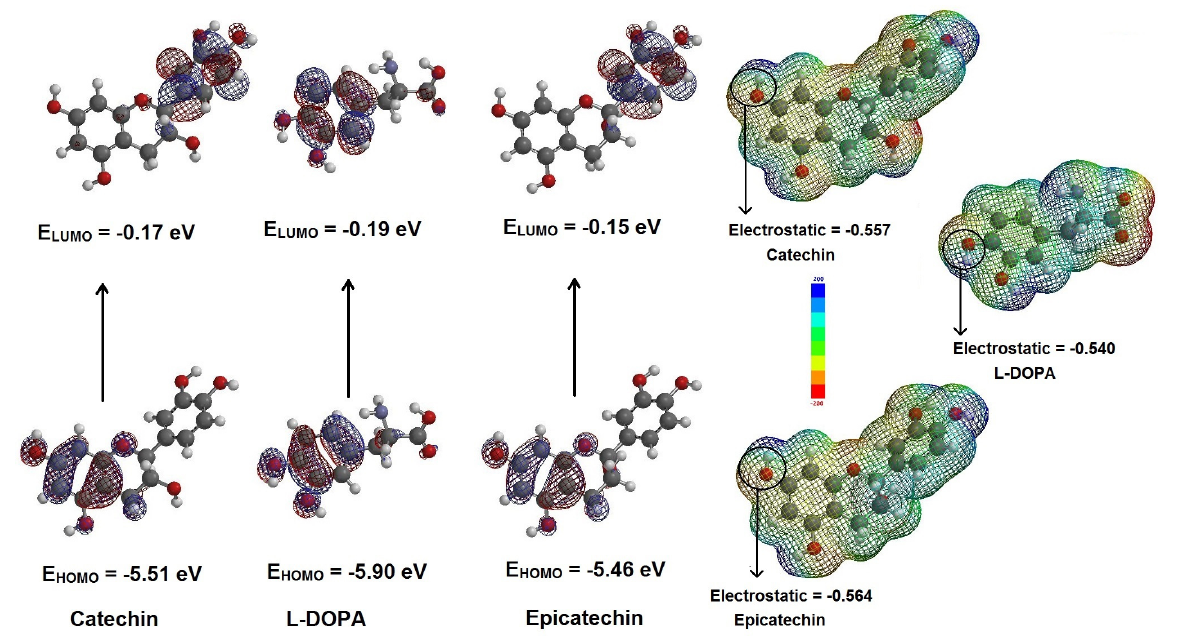
Figure 4. Theoretical HOMO-LUMO and electrostatic potential map (from the ground-state calculations at the DFT/ B3LYP/-6-31G* level - unit in kJ/mol) for catechin, L-DOPA and epi